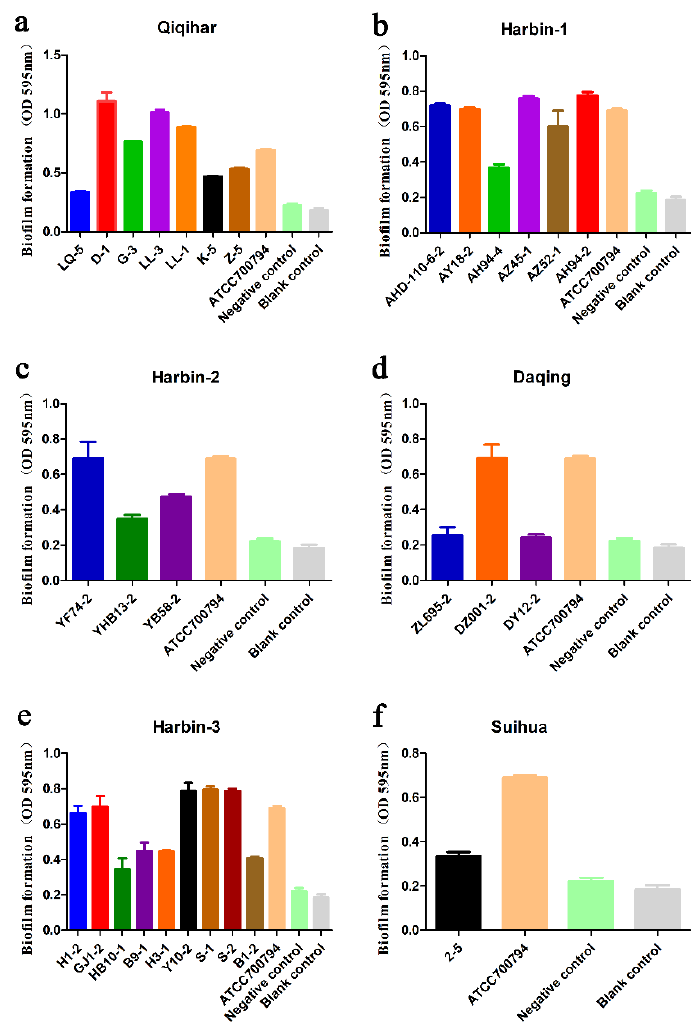
Figure 5. The ability of S. suis isolated from the six farms to form biofilm. Data are expressed as means ± standard deviations. S. suis ATCC 700794 was used as the positive control, and the negative control was culture with medium only. ( a ) The ability of S. suis isolated from Qiqihar pig farm to form biofilm; ( b ) The ability of S. suis isolated from Harbin-1 pig farm to form biofilm; ( c ) The ability of S. suis isolated from Harbin-2 pig farm to form biofilm; ( d ) The ability of S. suis isolated from Daqing pig farm to form biofilm; ( e ) The ability of S. suis isolated from Harbin-3 pig farm to form biofilm; ( f ) The ability of S. suis isolated from Suihua pig farm to form biofilm.